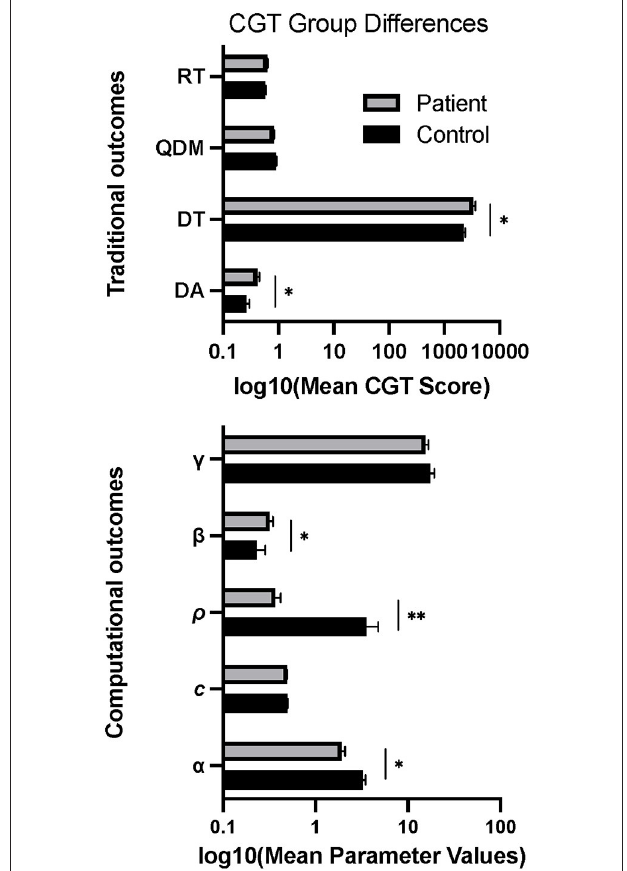
FIGURE 2 | Group differences in mean scores on behavioral and computational CGT measures. Error bars show standard error. * p < 0.05, ** p <